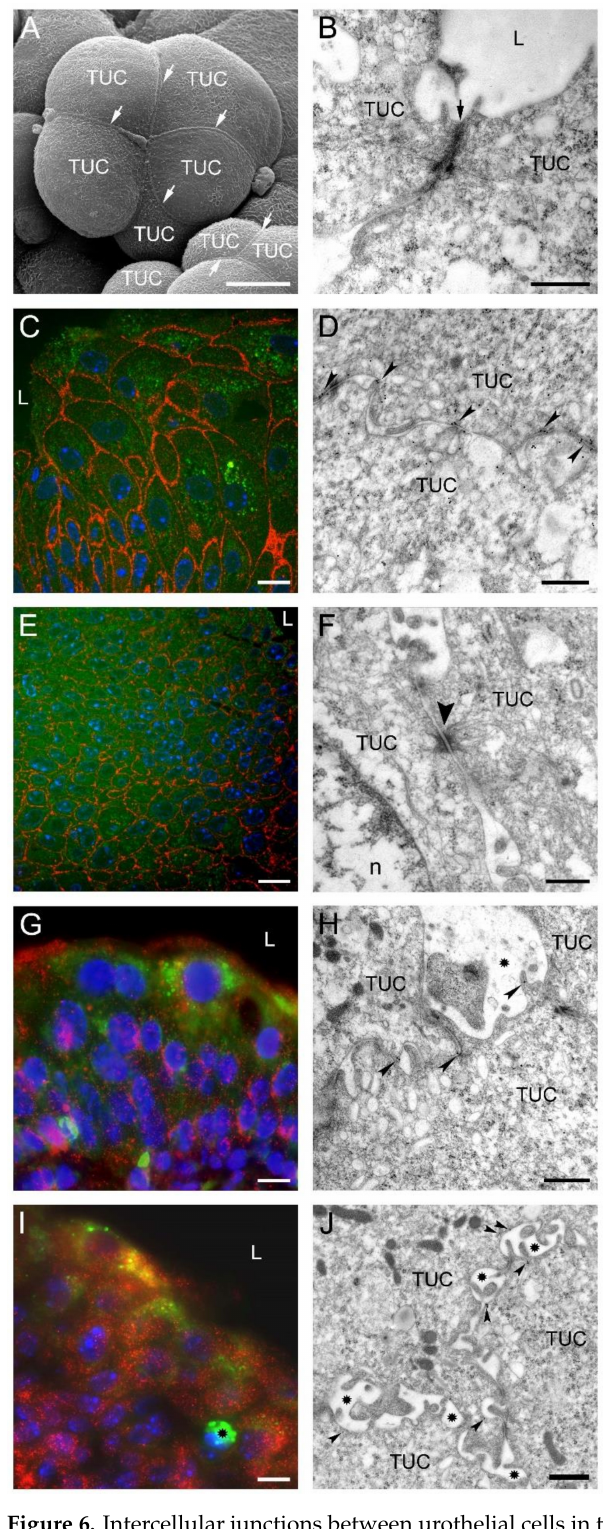
Figure 6. Intercellular junctions between urothelial cells in tumors developed 3 weeks after intrav- esical application of MB49-GFP cancer cells. Scanning electron micrograph ( A ) and transmission electron micrograph ( B ) of superficial tumor urothelial cells (TUC) connected by well-developed tight junctions (arrows). ( C ) Strong immunofluorescence reaction against β -catenin (red fluorescence) on boundaries of tumor urothelial cells (green fluorescence due to GFP). Nuclei were stained